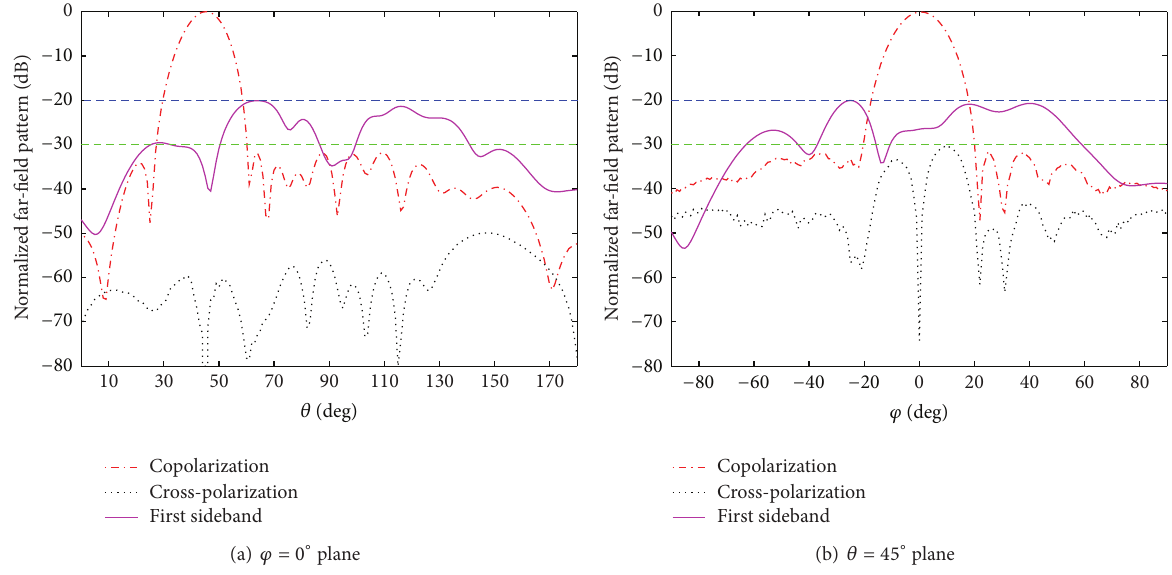
Figure 13: Sectional views in the elevation and azimuth planes for scan direction of (45 ∘ ,0 ∘ ) for solution A in Figure 7.